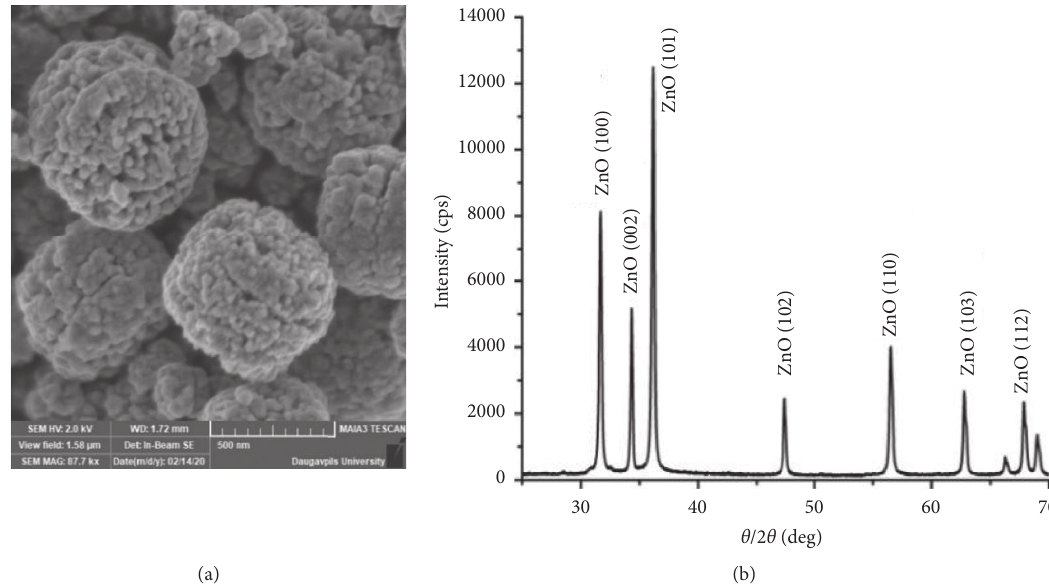
Figure 1: (a) SEM image of spherical agglomerates of ZnO nanostructures and (b) XRD pattern of ZnO nanostructured